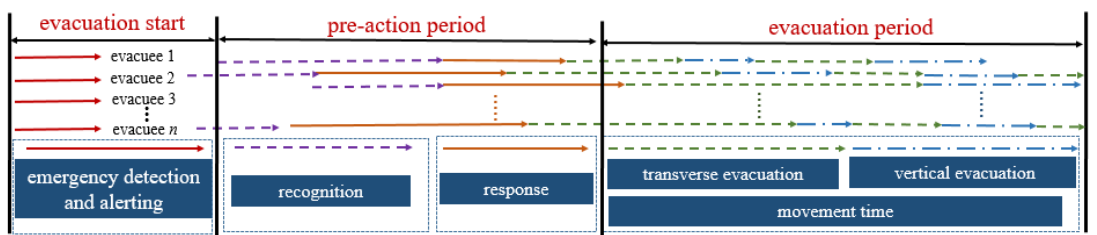
Figure 10. Time line in fire safety evacuation.